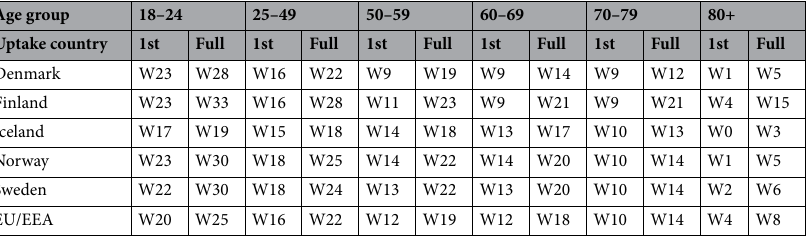
Table 3. The week number in 2021 where at least 10% of the population within the respective age groups had received the first vaccine dose (1st) and were fully vaccinated